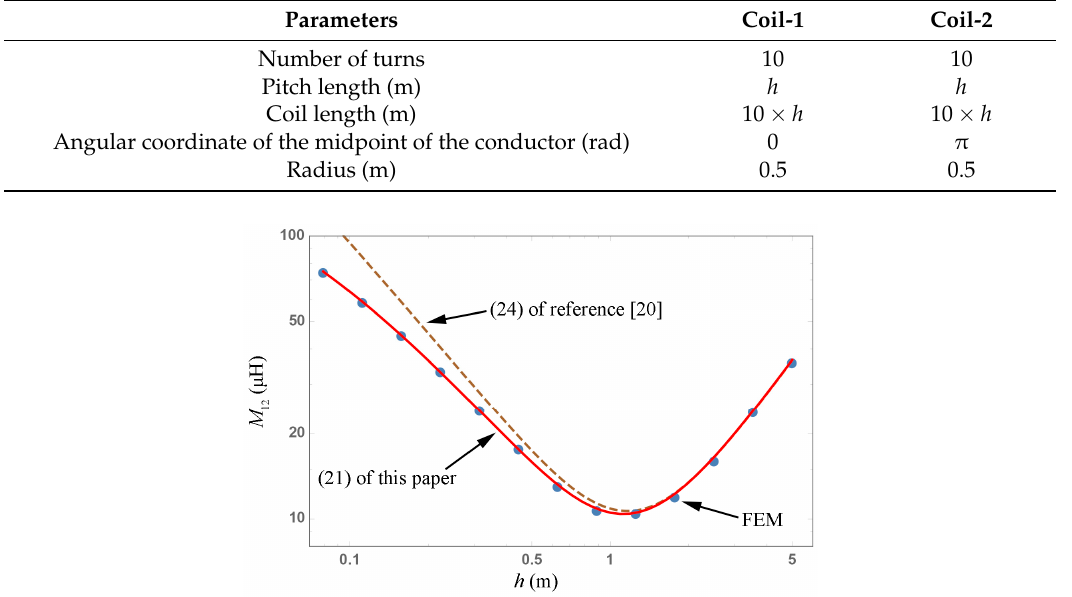
Table 5. Geometric parameters of the coils in Figure 2 (4th comparison). Parameters